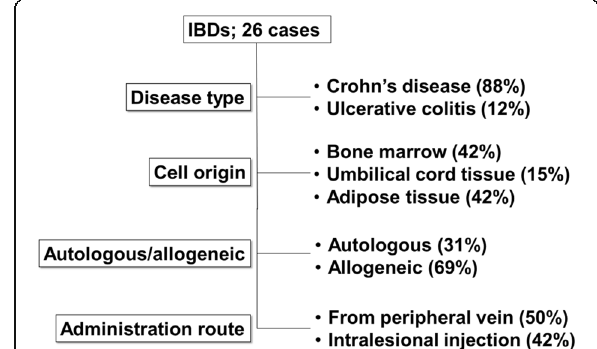
Fig. 2 Summary of clinical trials in inflammatory bowel